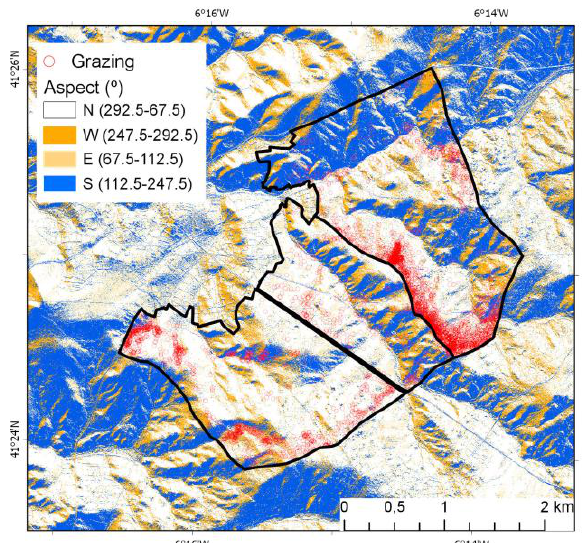
Figure 5. Aspect map with the GPS positions.